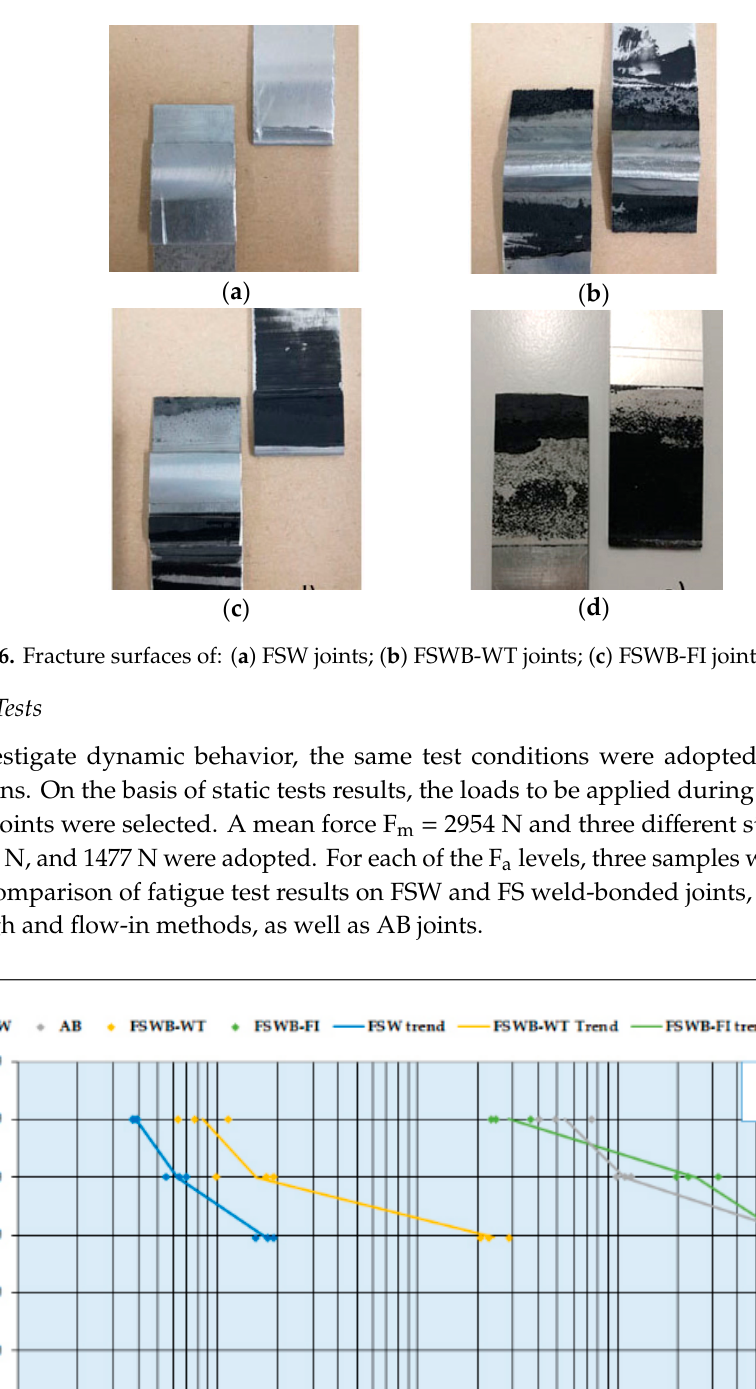
and AB joints. AB